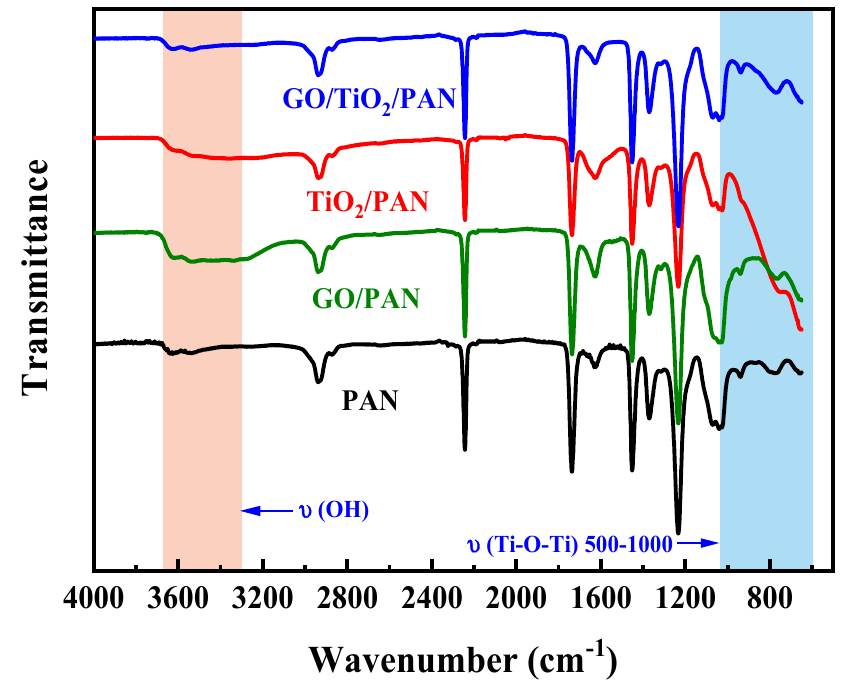
Figure 2. FTIR spectra of the PAN membrane and its MMMs. Strong peaks at 700 cm − 1 to 1000 cm − 1 in the spectra of the TiO 2 /PAN membrane were ascribed to the Ti-O-Ti structure [46], which demonstrates the in situ generation of the TiO 2 nanoparticles in the TiO 2 /PAN membrane during the NIPS. Due to the exchange of solvent (the DMAc) and non-solvent (DI water) between membrane matrix and coagula- tion bath, the sol–gel reaction of TBT occurs when it comes into contact with the DI water. This forms TiO 2 nanoparticles in the membrane matrix [43]. Moreover, what’s particularly interesting is that, despite the same amount of the precursor (TBT) being added to the casting solutions, higher absorption peak intensities at 700 cm − 1 to 1000 cm − 1 were ob- served in the TiO 2 /PAN than in the GO/TiO 2 /PAN membrane. Figure 3. XPS spectra of the PAN, TiO 2 /PAN and GO/TiO 2 /PAN membranes. * indicates the ele- ment being analyzed. As shown in Figure 3, the XPS data of membranes’ top surfaces also indicate that TiO 2 nanoparticles were observed on the top surfaces of both the TiO 2 /PAN and GO/TiO 2 /PAN membranes (as shown by the Ti–O–Ti peak in the O1s). A higher content of Ti was detected on the top surface of the TiO 2 /PAN membrane (1.33%) than the